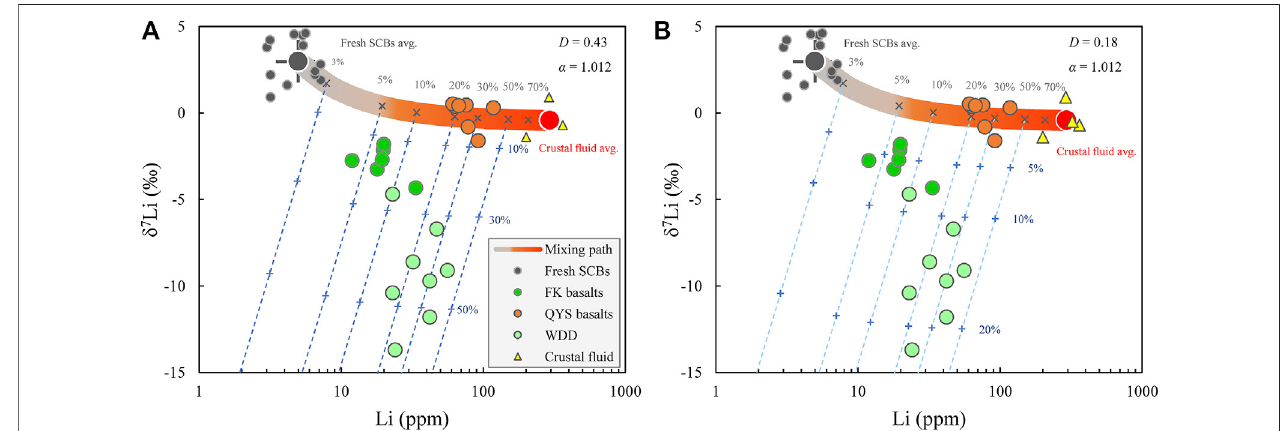
FIGURE 4 | Conceptual model for the genesis of QYS and FK basalts. The two end members of the mixing path as hydrothermal alteration are the average fresh SCBs(Li:5.0 ± 1.5ppm; δ 7 Li: 3.0± 1.2 ‰ , n= 13, 1 σ ) and the averagemagmatic-hydrothermal fl uid from theVariscan granites,Southwest England (Li:294 ±60 ppm; δ 7 Li: 0.43 ± 0.8 ‰ , n = 4, 1 σ ) (Richard et al., 2018). The dashed blue lines represent weathering, modeled using Rayleigh distillation, and was applied to hydrothermally altered basaltsusing Eqs1 , 2 with α =1.012,andD=0.18 (A) andD=0.42 (B) .Thenumbersnexttothedashedbluelinesin (A) and (B) arethefraction ofriverine water relative to the weathering rocks, which represent the weathering degree of